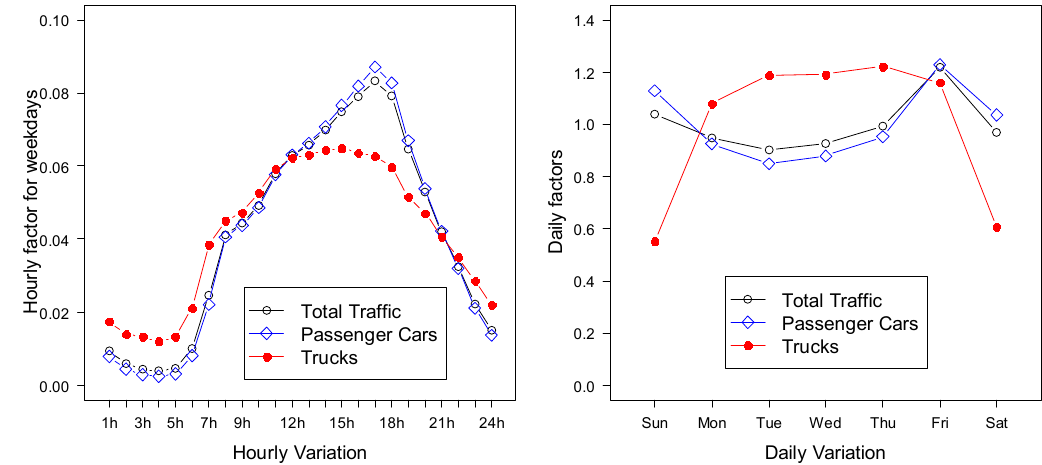
Figure 5. Typical hourly and daily variations of traffic at Red Deer Highway 2.